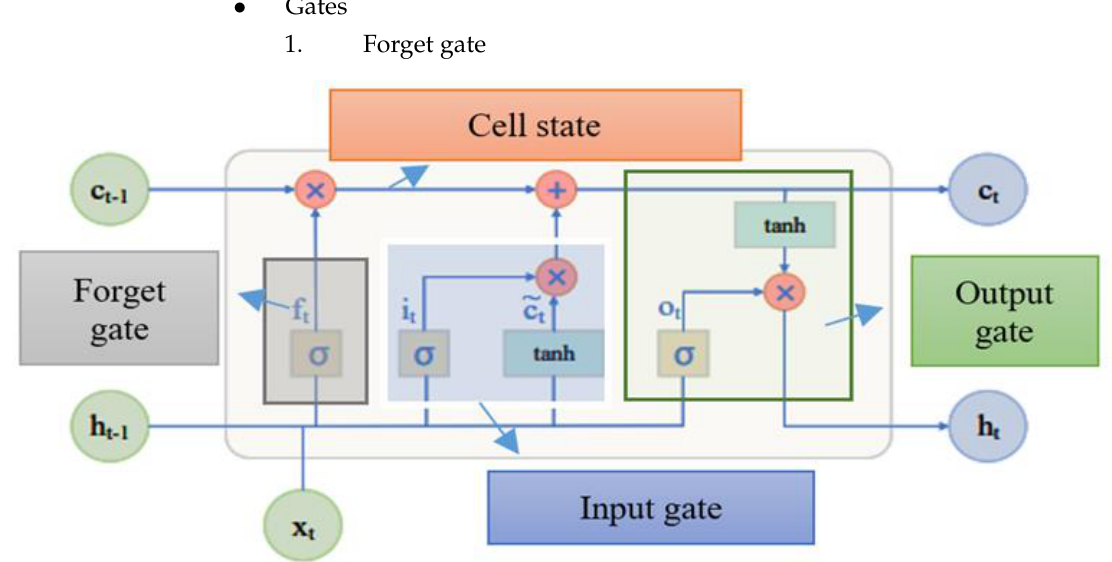
Figure 7. Basic architecture of LSTM model.